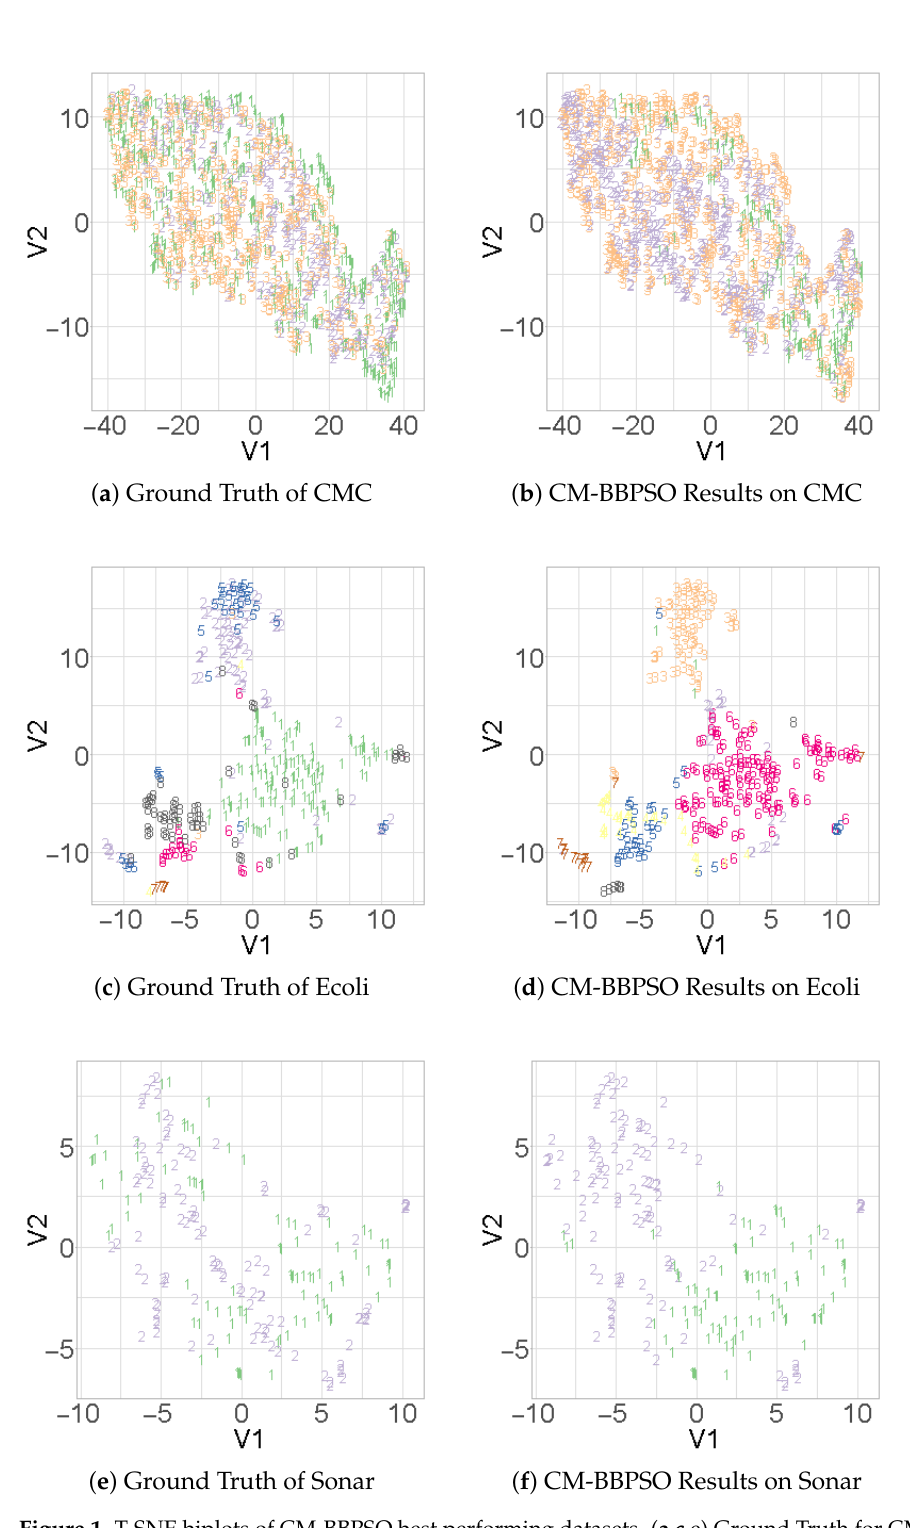
Figure 1. T-SNE biplots of CM-BBPSO best performing datasets. ( a , c ,e) Ground Truth for CMC, Ecoli and Sonar, respectively, and their corresponding CM-BBPSO results in ( b , d , f